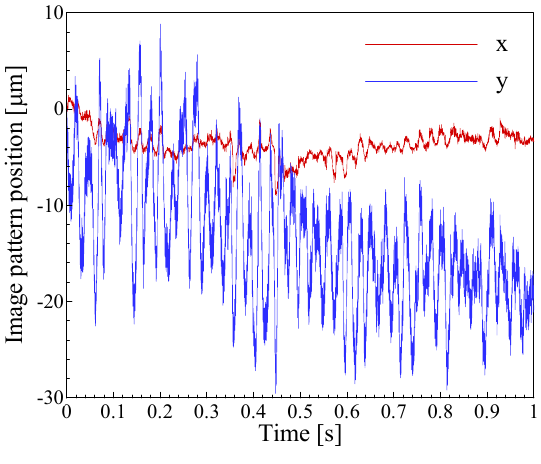
Figure 14. Position time histories of a fire ant antenna hair tip.